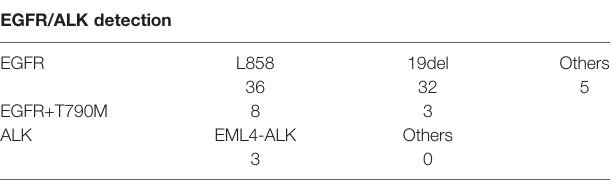
TABLE 2 | EGFR/ALK detection in 124 CSF